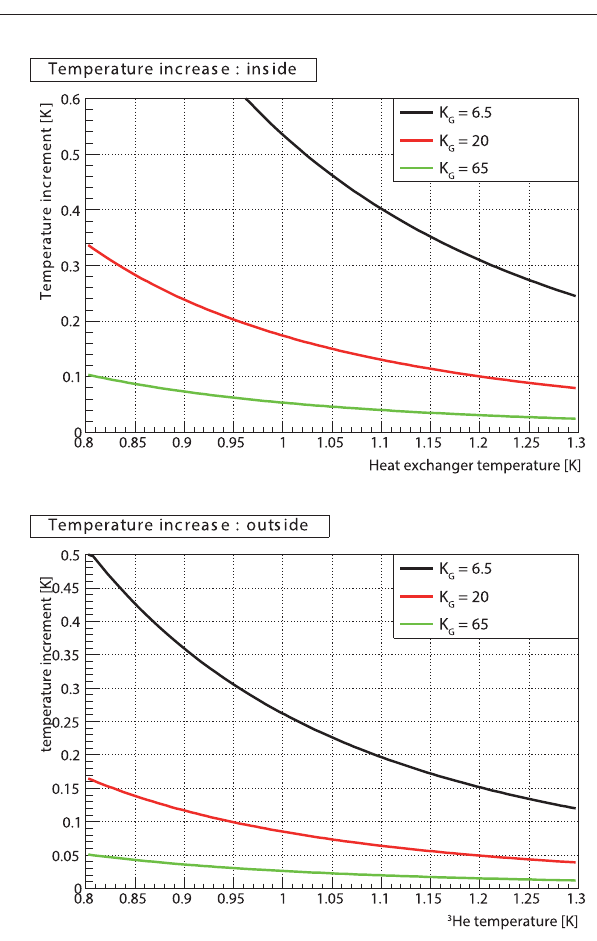
Figure 4. Temperature difference across liquid-solid interface owing to the Kapitza conductance at the heat exchanger for a 10-W heat load, inside (top), outside (bottom). Values are calculated using a = 2 . 6 (see Eq. (6)).